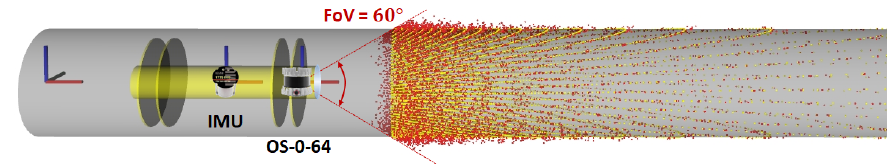
Figure 8. A PIG in a cylindrical